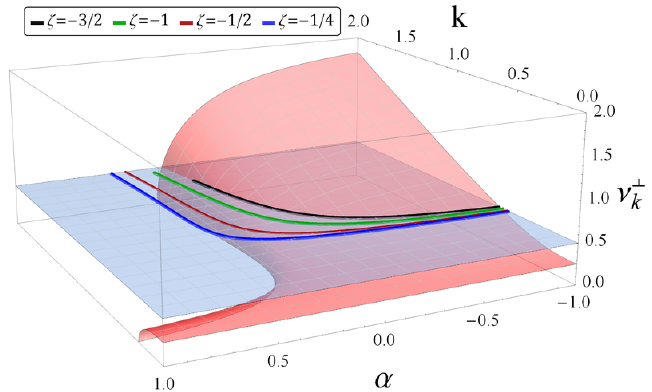
Figure 11. This plot illustrates the combined e(cid:11)ect of the Chern-Simons coupling (cid:11) and the massive vector (via the exponent (cid:16) ) on the exponent (cid:23) ? the (cid:23) ? = 1 = 2 plane no spectral weight exists. The curves plotted in the (cid:23) ? k the critical momentum k (cid:3) for di(cid:11)erent values of (cid:16) .